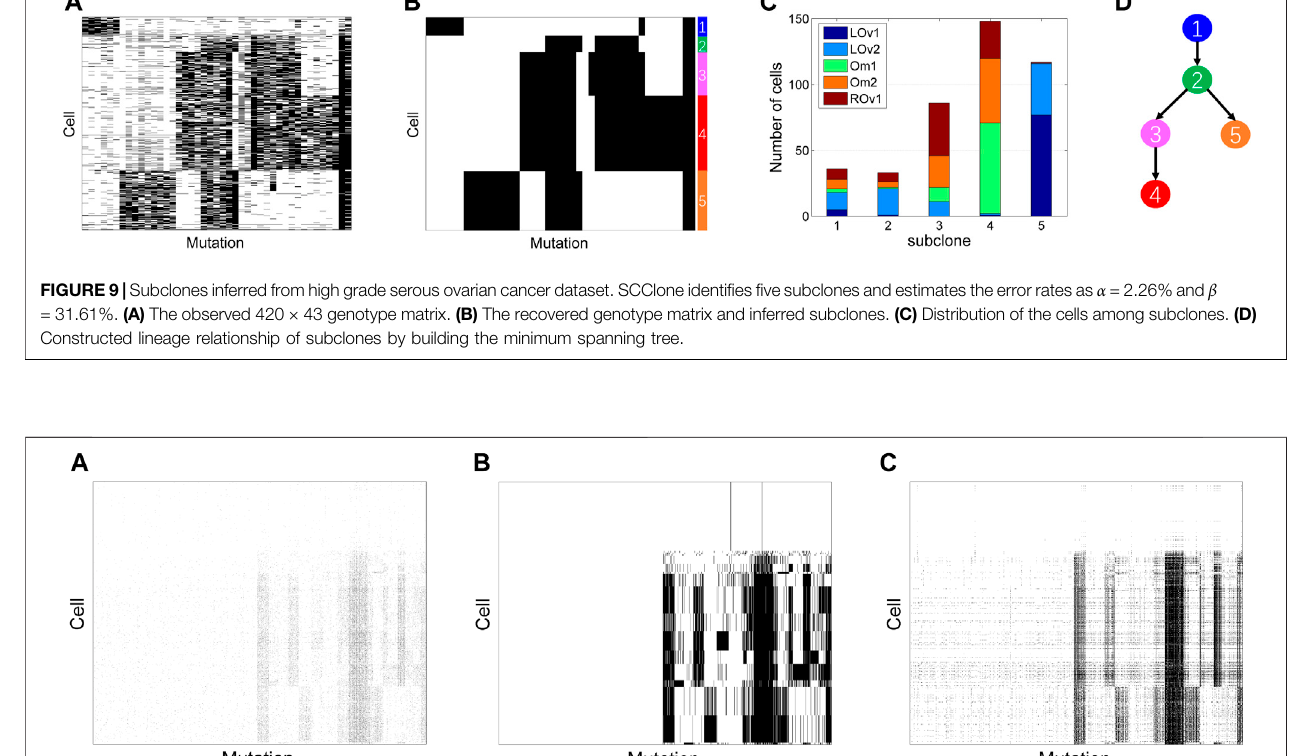
Figure 9A . The cells are collected from the left ovary (LOv), right ovary (ROv), and omentum (Om). We apply SCClone on this dataset to infer clonal composition. It fi nds fi ve subclones (labeled